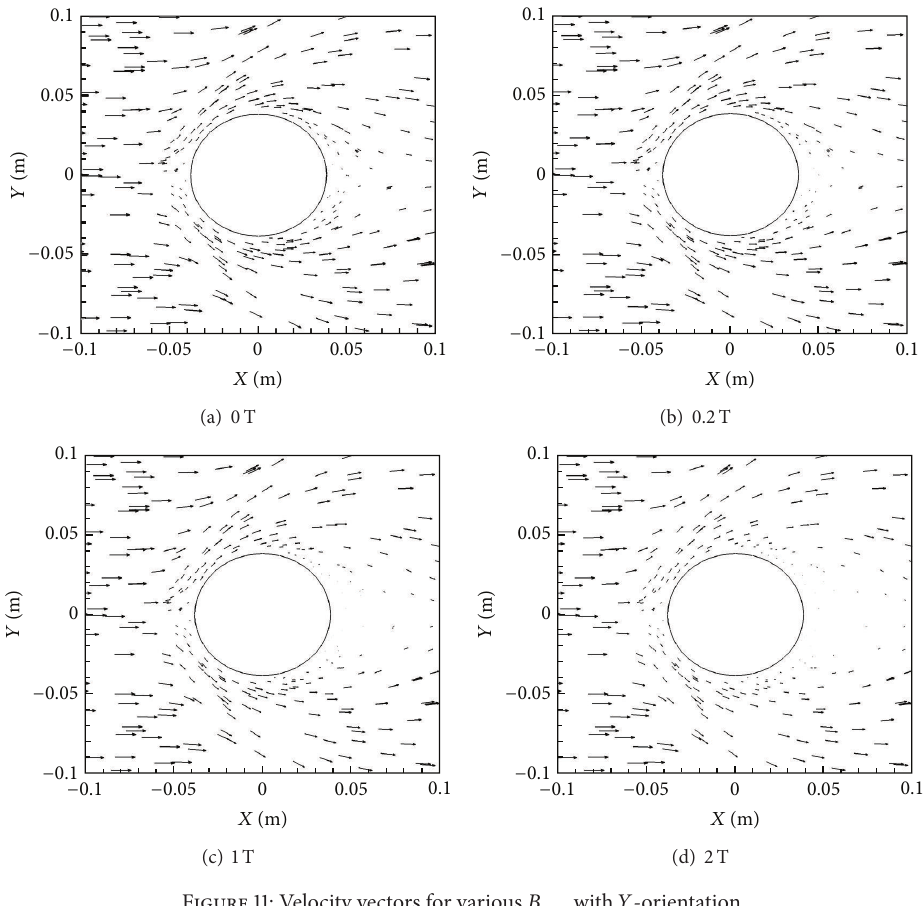
Figure 11: Velocity vectors for various 𝐵 max with 𝑌 -orientation.